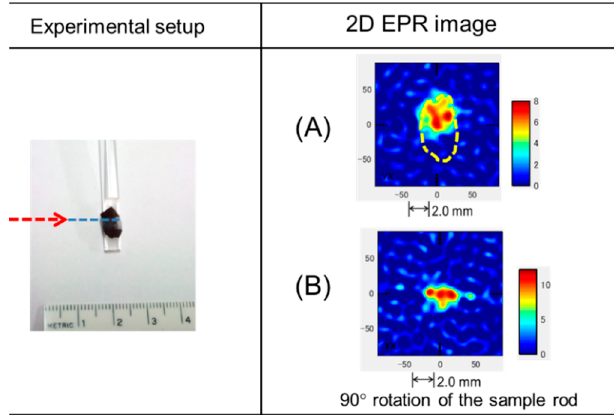
Figure 6. The left-hand panel shows the measurement set-up. The right-hand panel displays a 2D-EPR image of a C. japonica seed. The red-dotted arrow indicates the edge of the seeds. The dotted line in ( A ) shows the approximate size of the samples. The EPR image in ( B ) was taken at a 90-degree rotation compared to ( A ) position.